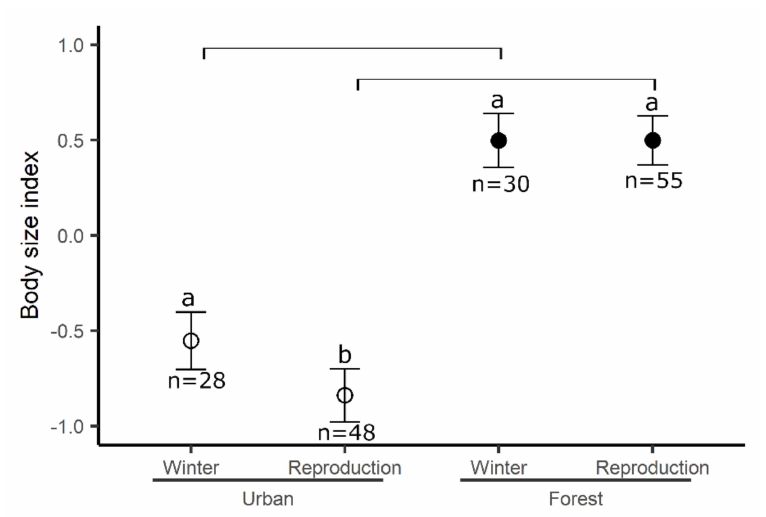
Figure 1. The body size of birds between sites across seasons. Means and standard errors are represented. Different letters represent significant differences between seasons for the same site and bars represent the difference between sites for the same season (see text for details).